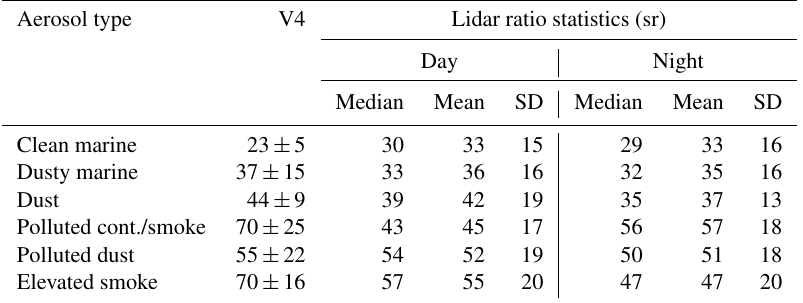
Table 4. Median, mean, and standard deviation of CALIPSO–SODA lidar ratio associated with each tropospheric aerosol subtype. Statistics exclude profiles with 80km horizontal